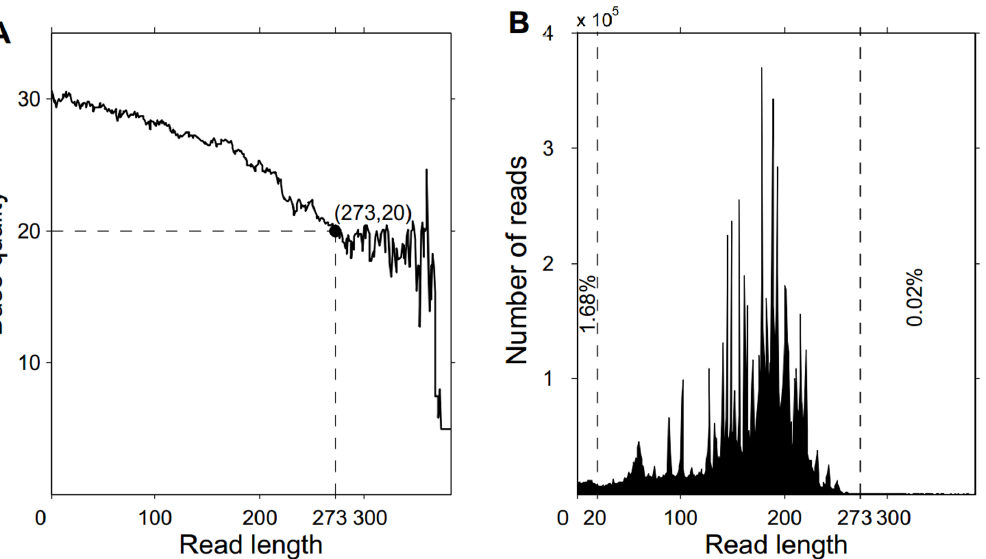
Figure 1. Selection criteria for trimmed reads. (A) The relationship between base quality and read length in the raw data. (B) The relationship between number of reads and read length in the raw data.